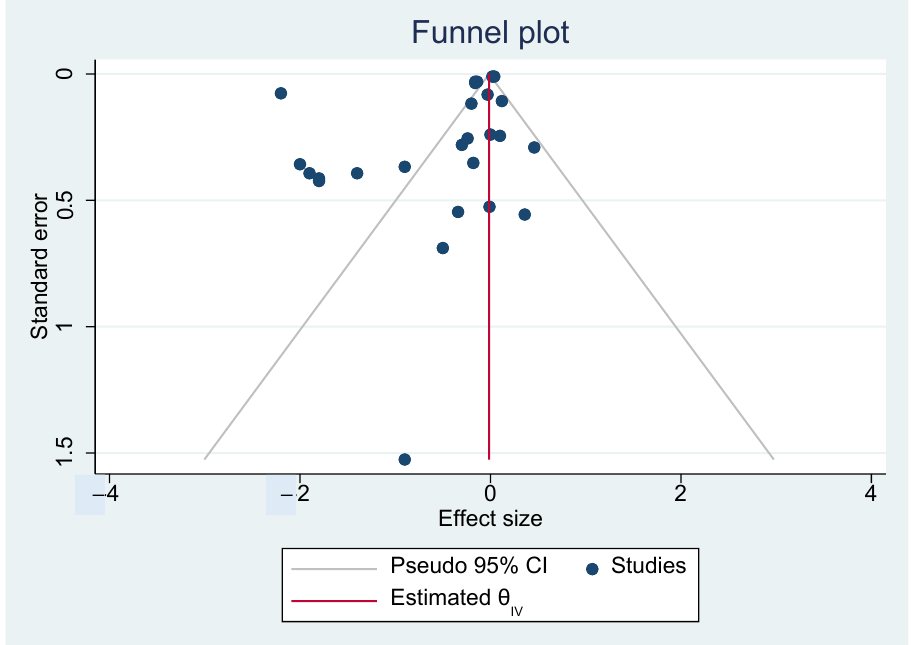
Figure 6. Funnel plot of effects.